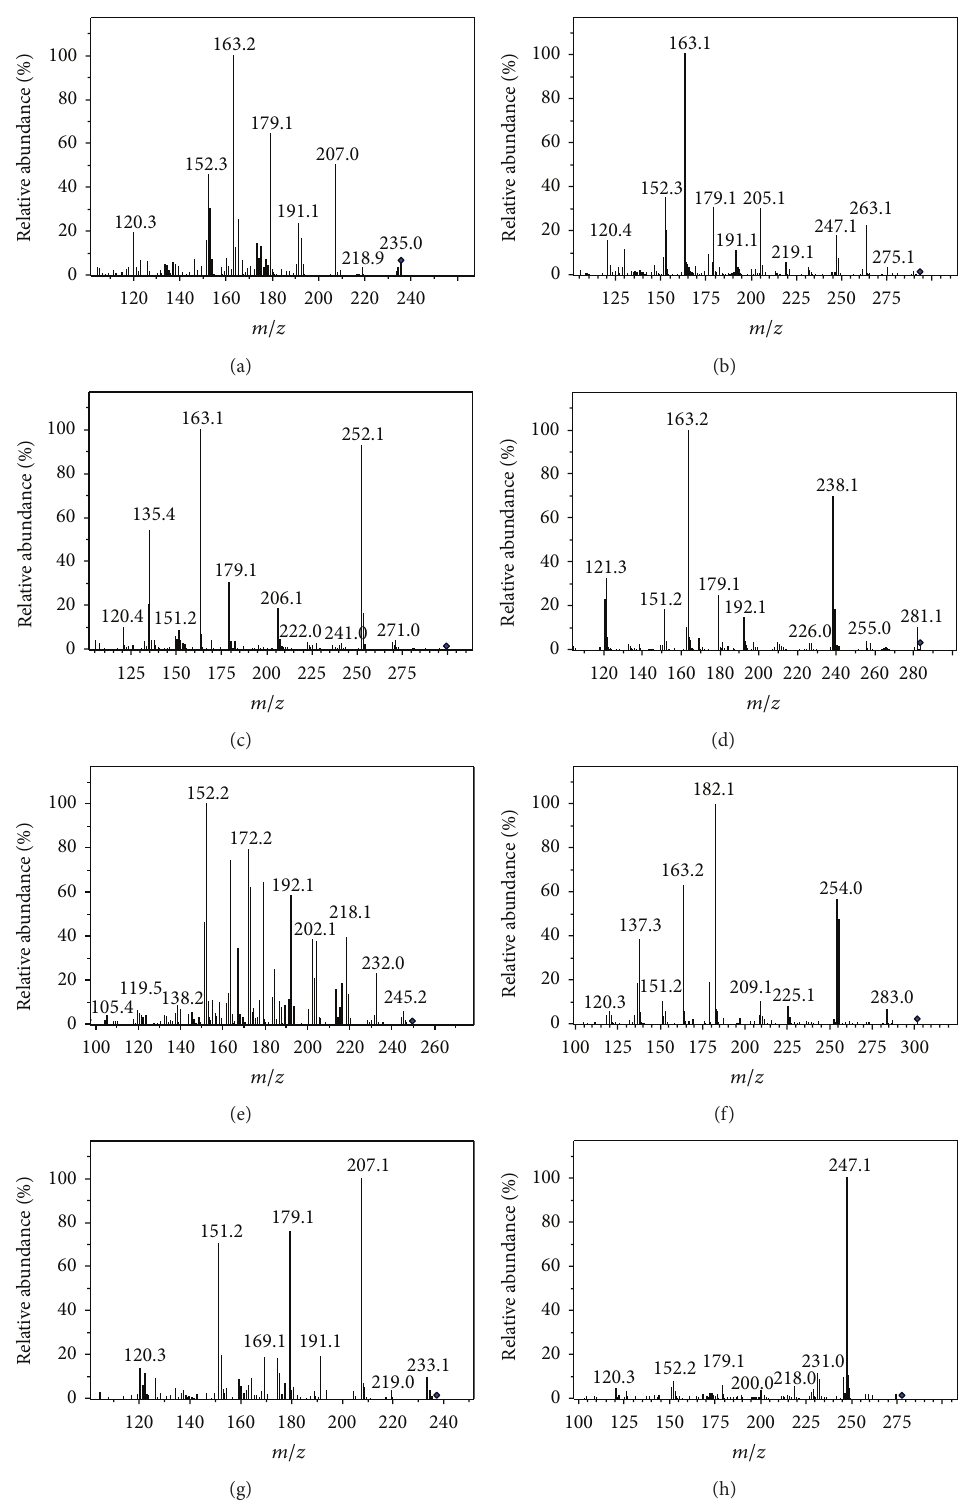
Figure 3: MS/MS spectra obtained from the [M-H] − ion fragmentation of selected hydrazones: (a) propionaldehyde; (b) heptanaldehyde; (c) o-, m-, and p-tolualdehydes; (d) benzaldehyde; (e) crotonaldehyde; (f) salicylaldehyde; (g) acetone; and (h)